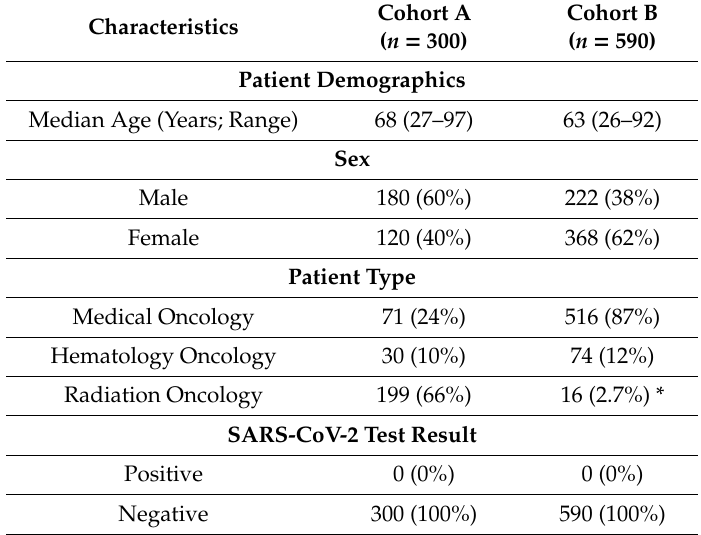
Table 1. Clinical characteristics of each cohort tested for SARS-CoV-2. * Concurrent chemoradiation.